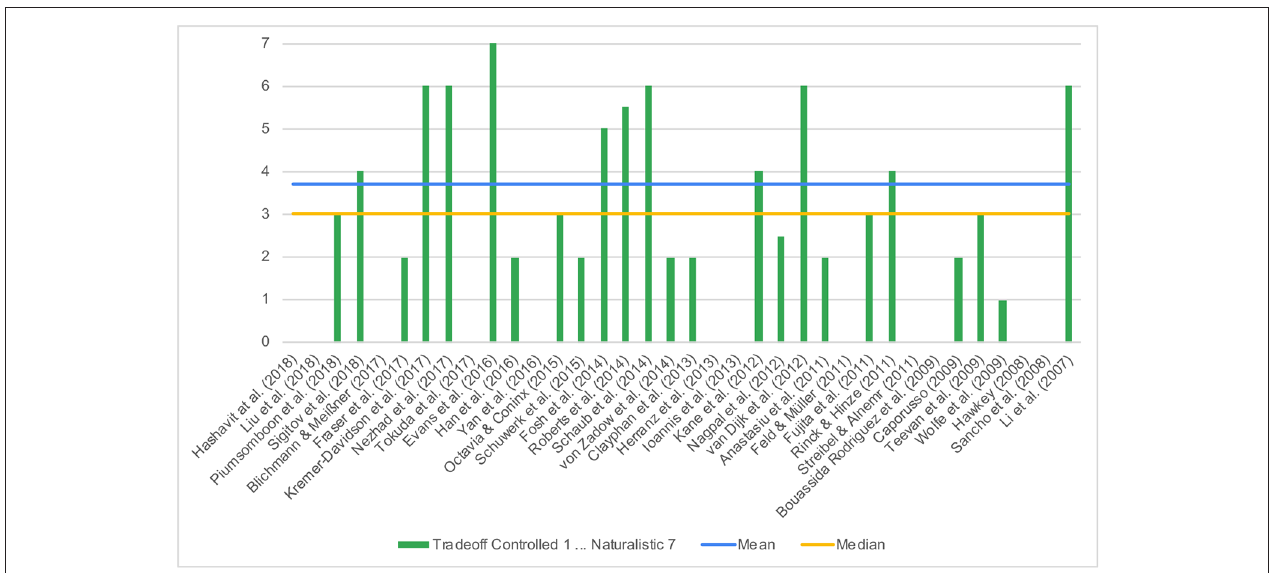
FIGURE 5 | Overview of the tradeoff between internal and external validity resulting from controlled (1) vs. naturalistic (7) study